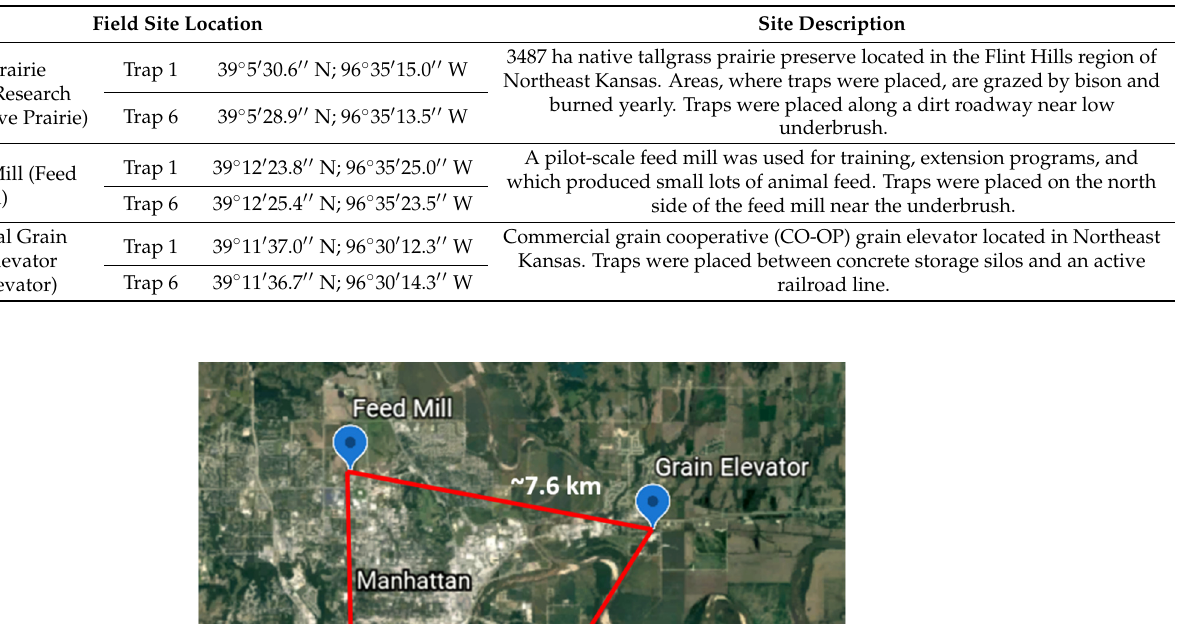
Table 1. Description and location (latitude and longitude of the traps at each end of the transect) of field sites.